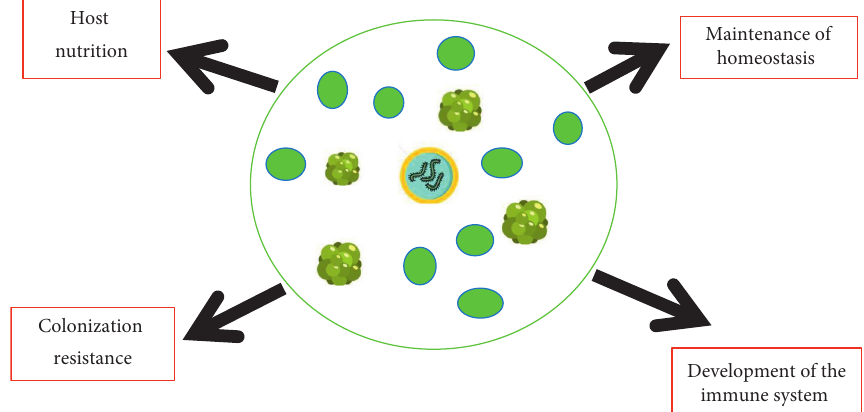
Figure 3: Symbiotic interaction between eubiotic flora and the human body results in the maintenance of homeostasis, regulation, and development of the immune system, hosts nutrition, and colonization